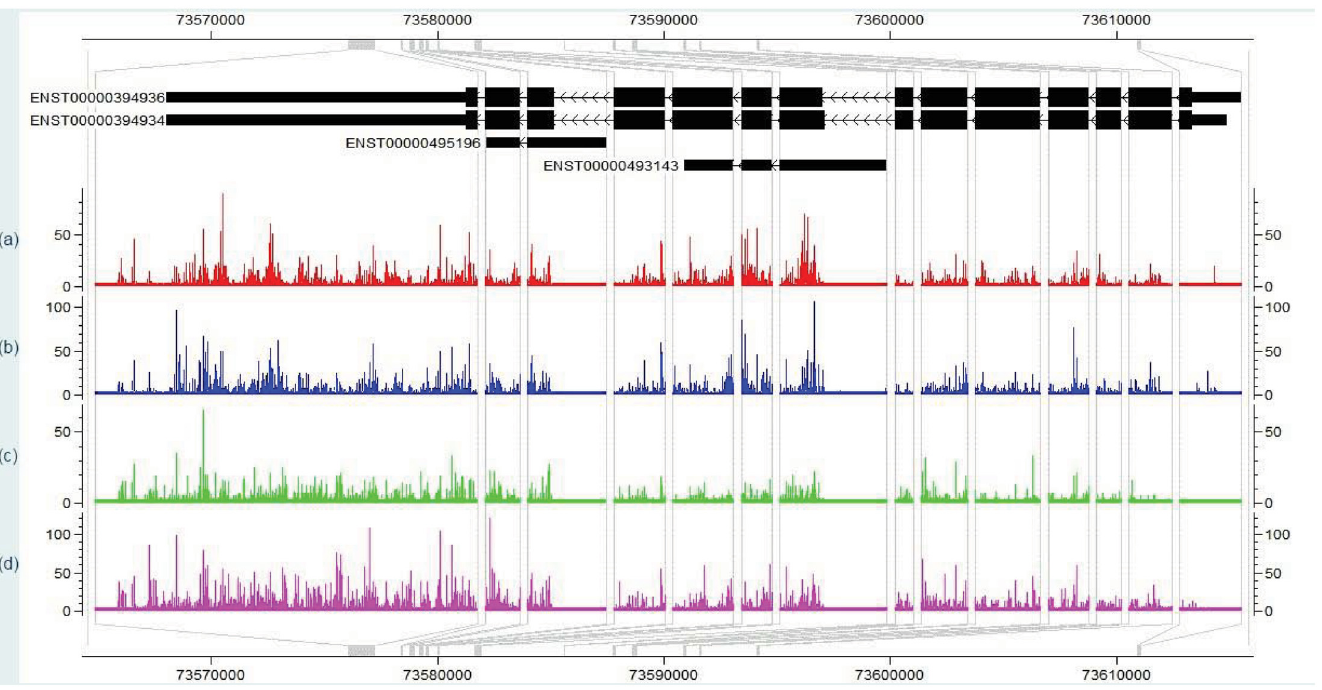
Fig 1. Read counts for each exonic nucleotide (nt) position in CisGenome Browser [19] along gene ENSG00000197746 (PSAP) in different tissues of the Human Body Map dataset (a) brain, (b) breast, (c) liver and (d) lung. Counts for reads starting at each exonic nucleotide position are shown.